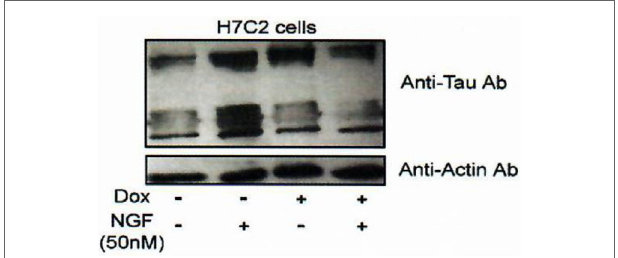
FIGURE 6 | Effect of FKBP52 overexpression on Tau protein accumulation. H7C2 cells: stably transformed PC12 cells by an FKBP52-inducible expression system based on a tetracycline responsive element (82). NGF: 5 days—Dox: 7 days. H7C2 and PC12 cells were treated or not with NGF for 5 days in the presence or absence of DOX for 1 week; 50 µg of extracts was subjected to SDS-PAGE and immunoblotted with anti-Tau (antibody clone DC25). Actin was used as the loading control. Data from Chambraud et al. (4).